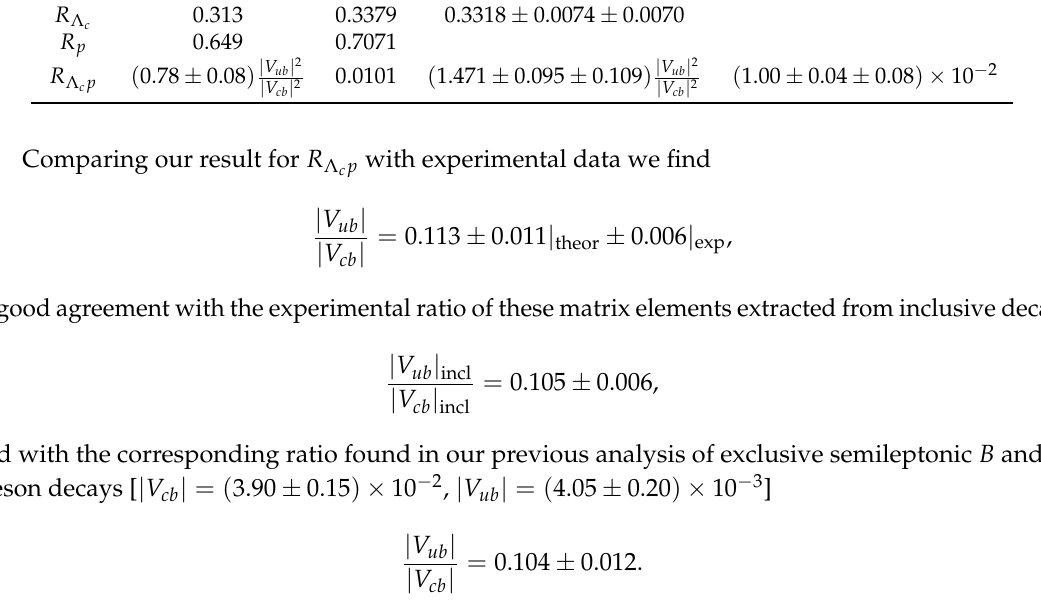
Table 2. Comparison of theoretical predictions for the ratios of the decay rates with experimental data. Our Dutta Lattice Experiment Ratio [1] [17] [21] LHCb